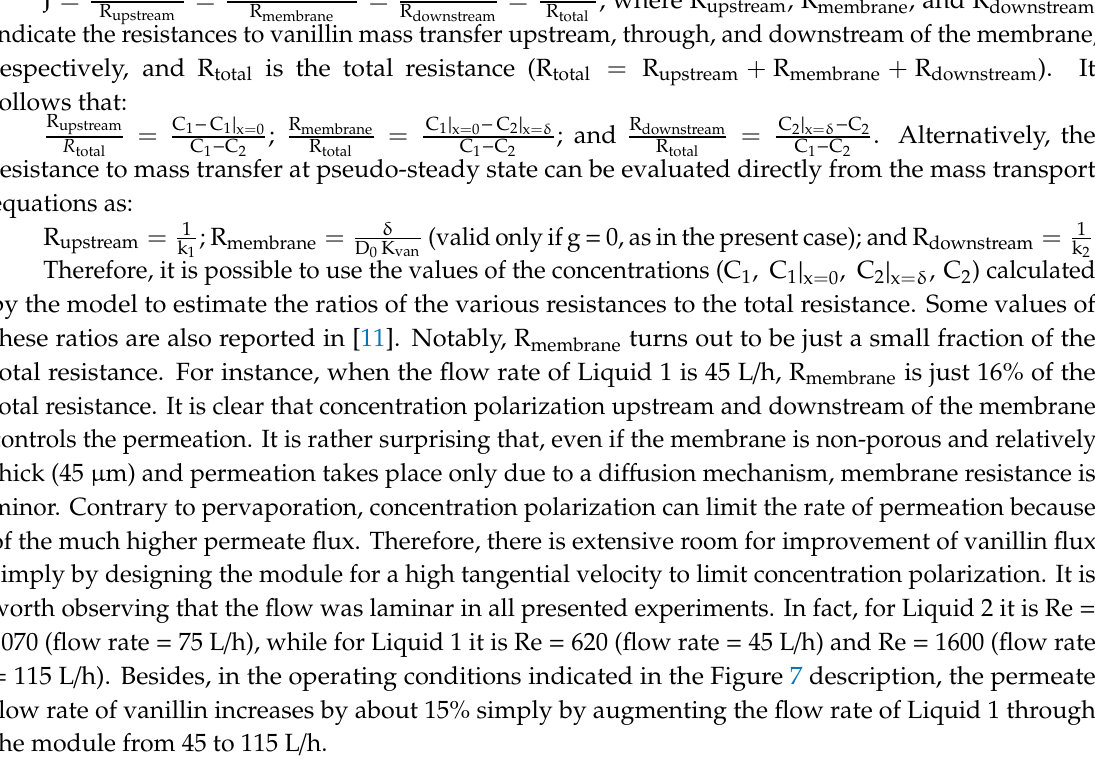
Figure 7. Flux density of vanillin vs. time, as predicted by the model. Upstream of the membrane (dotted lines), in the middle of the membrane at x = δ / 2 (dashed lines), and downstream of the membrane (continuous lines). Flow rate of Liquid 1: 45 L / h (red lines) and 115 L / h (blue lines). For